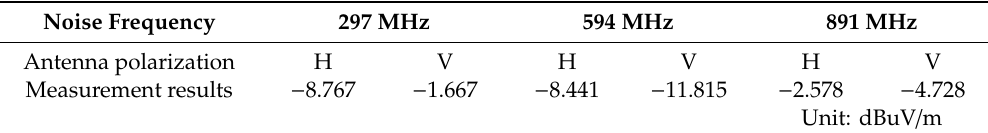
Table 1. EMI measurement data of PCB first edition.